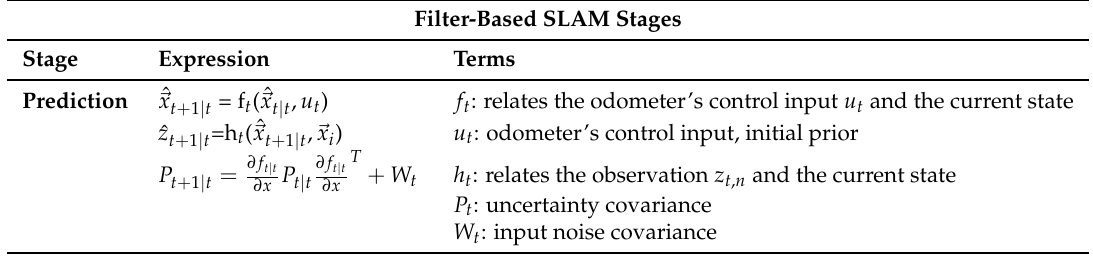
Table 1. EKF-based Filter: Prediction stage.